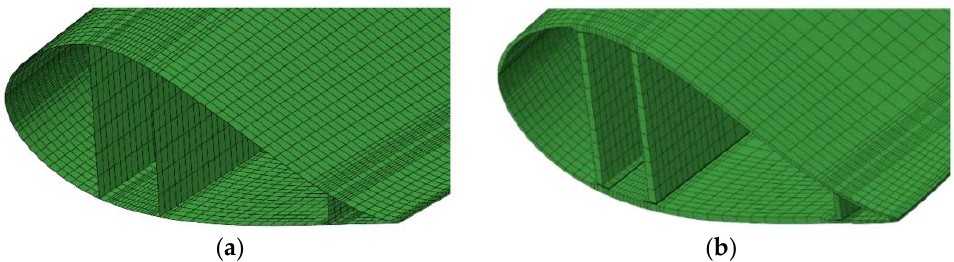
Figure 8. The 3D FEM structure models: ( a ) shell element model; ( b ) solid element model